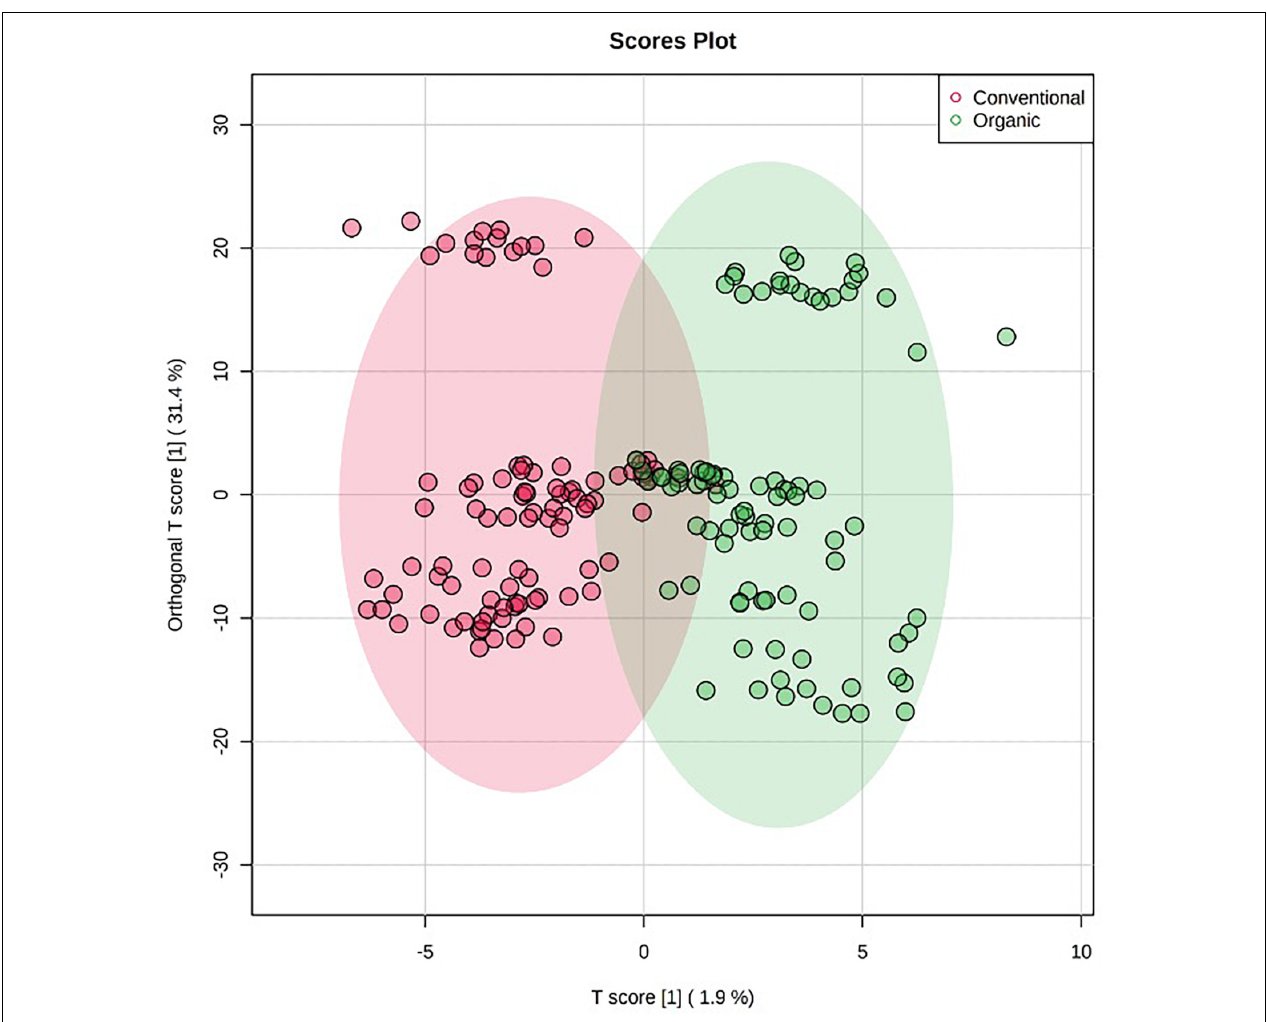
FIGURE 3 | Orthogonal projections to latent structures discriminant analysis (OPLS-DA) score plot supervised modeling relative to untargeted metabolomics profile of tomato samples, built specifically considering the impact of farming system (i.e., organic vs. conventional) on the phytochemical profiles of tomato